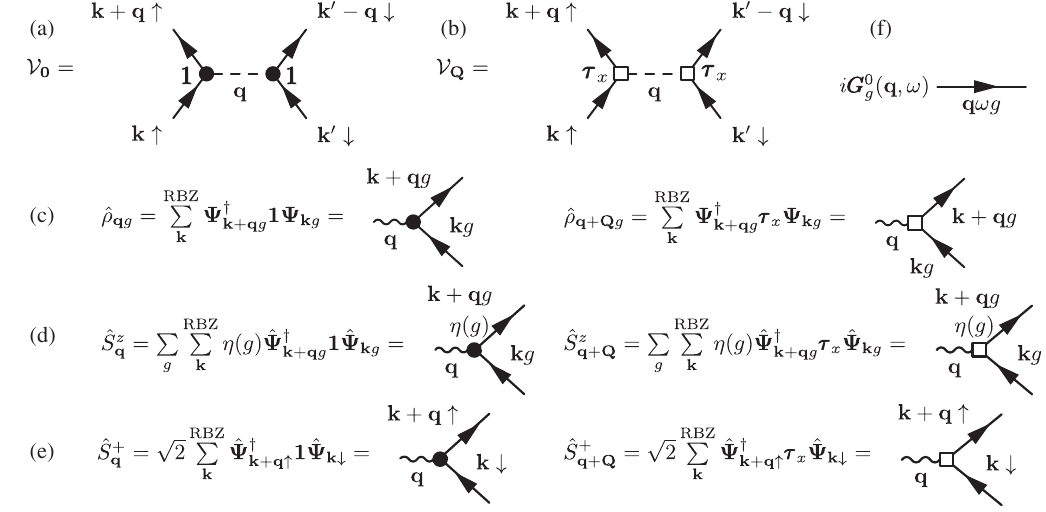
FIG. 25. Diagrammatic representation of the interaction vertices, spin densities, and Green ’ s function needed for the RPA calculation of the susceptibilities. Panels (a) and (b) show the interaction vertices [Eq. (A1)], (c) shows the density operator [Eq. (32)], (d) shows the spin projection on the z direction [Eq. (30)], (e) shows the spin-raising operator [Eq. (31)], and (f) shows the MFT Green ’ s function [Eq.